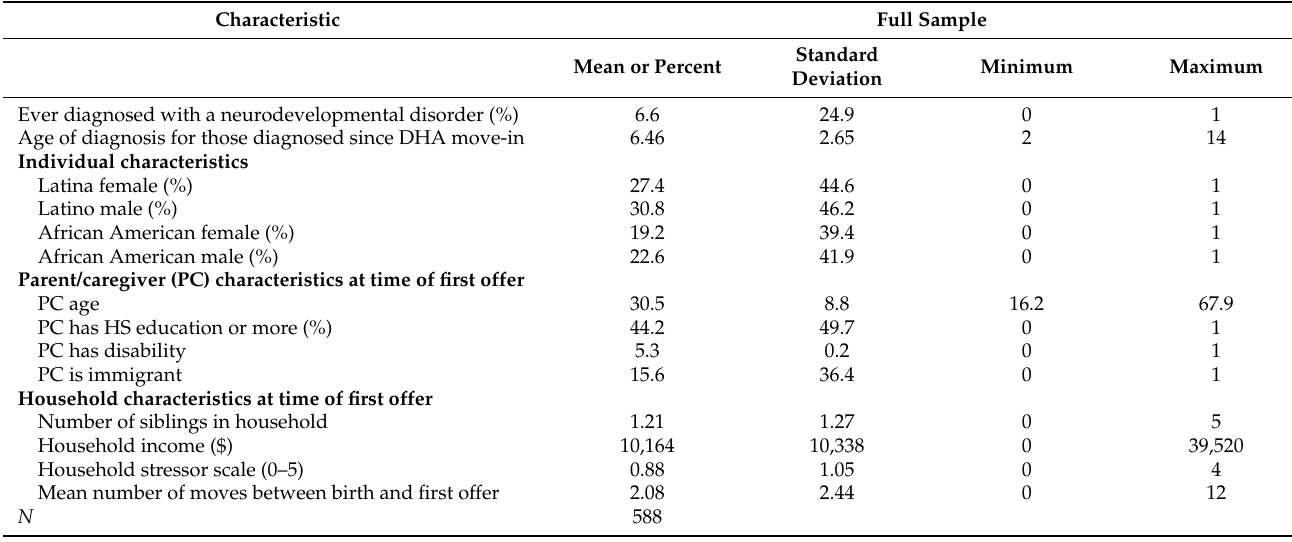
Table 1. Child, Parent and Household